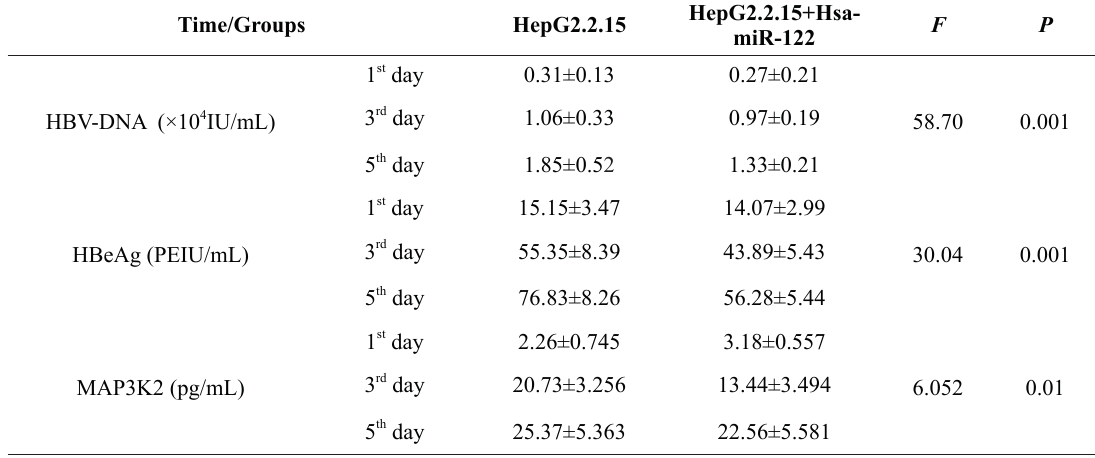
Detection of the number of HBV-DNA copies, the levels of HbsAg and MAP3K2 in the cell culture supernatant at different time